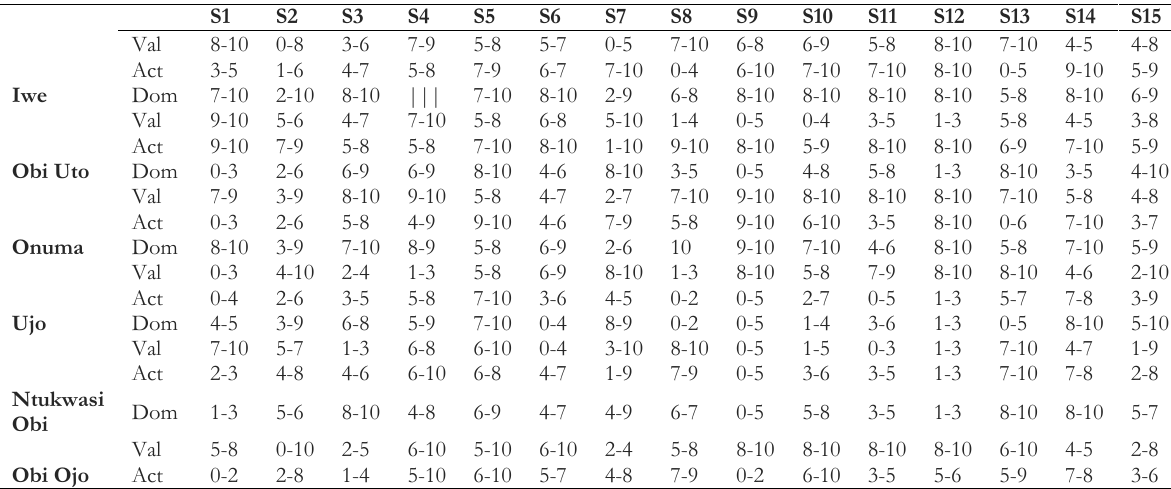
Table 4. Parts of the data intervals collected from the subjects.